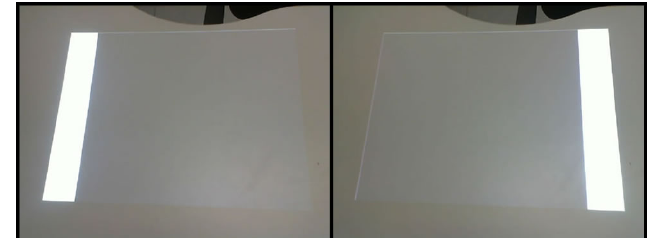
Fig. 9. Structured lights projected in sequence so the alignment can be calculated.